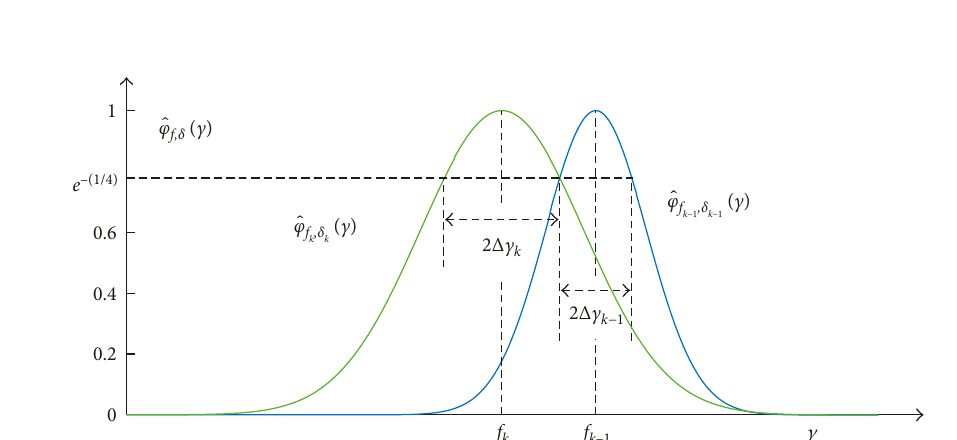
Figure 1: Schematic diagram for sampling φ